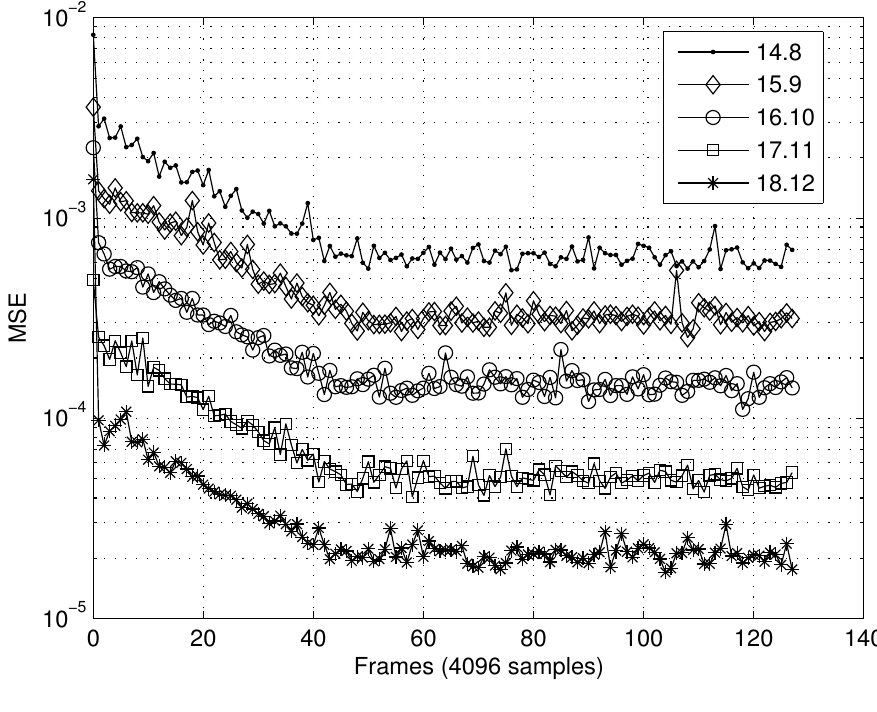
Figure 8. Performance of the RBF in tests using the sine function